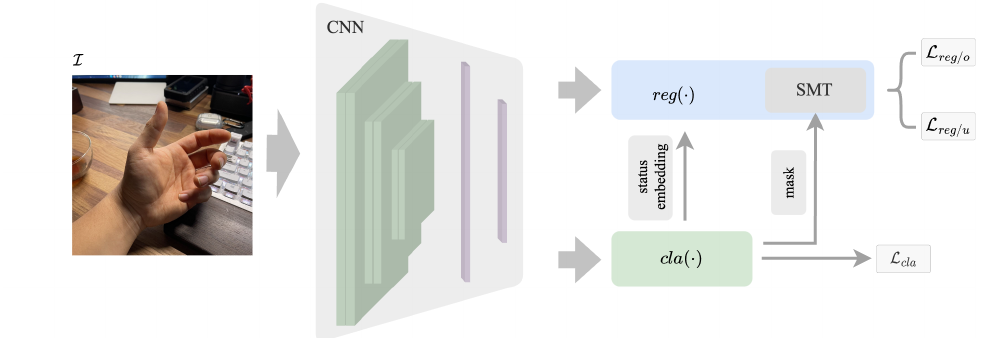
Figure 2. Overview of the proposed PA-Tran framework. Given an input image I , we extract the image features using a convolution neural network. Then the image features are passed into two separate branches: the regression branch reg ( · ) and the classification branch cla ( · ) . cla ( · ) will generate the status embedding for reg ( · ) and masks for SMT to learn the interaction between labels. The structures of reg ( · ) and cla ( · ) are detailed in Section